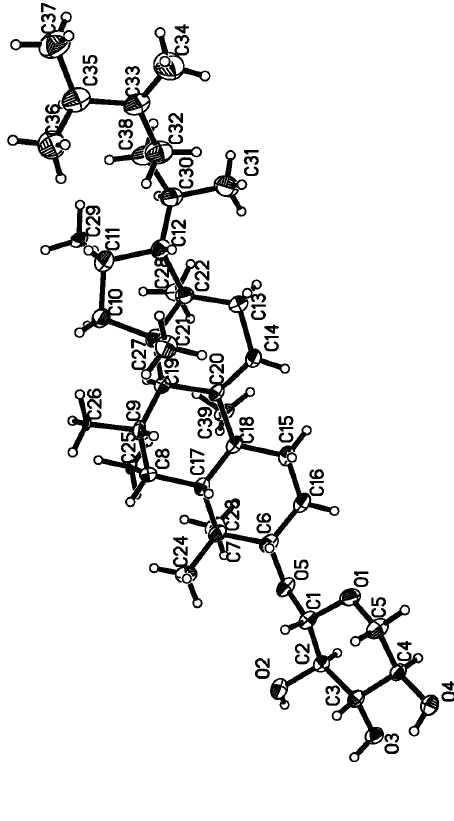
Figure 3. Perspective drawing of compound 1 generated from X-ray crystal